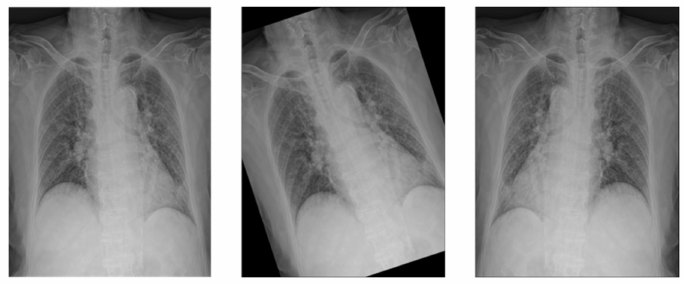
Figure 10. X-ray image with Rand Augment